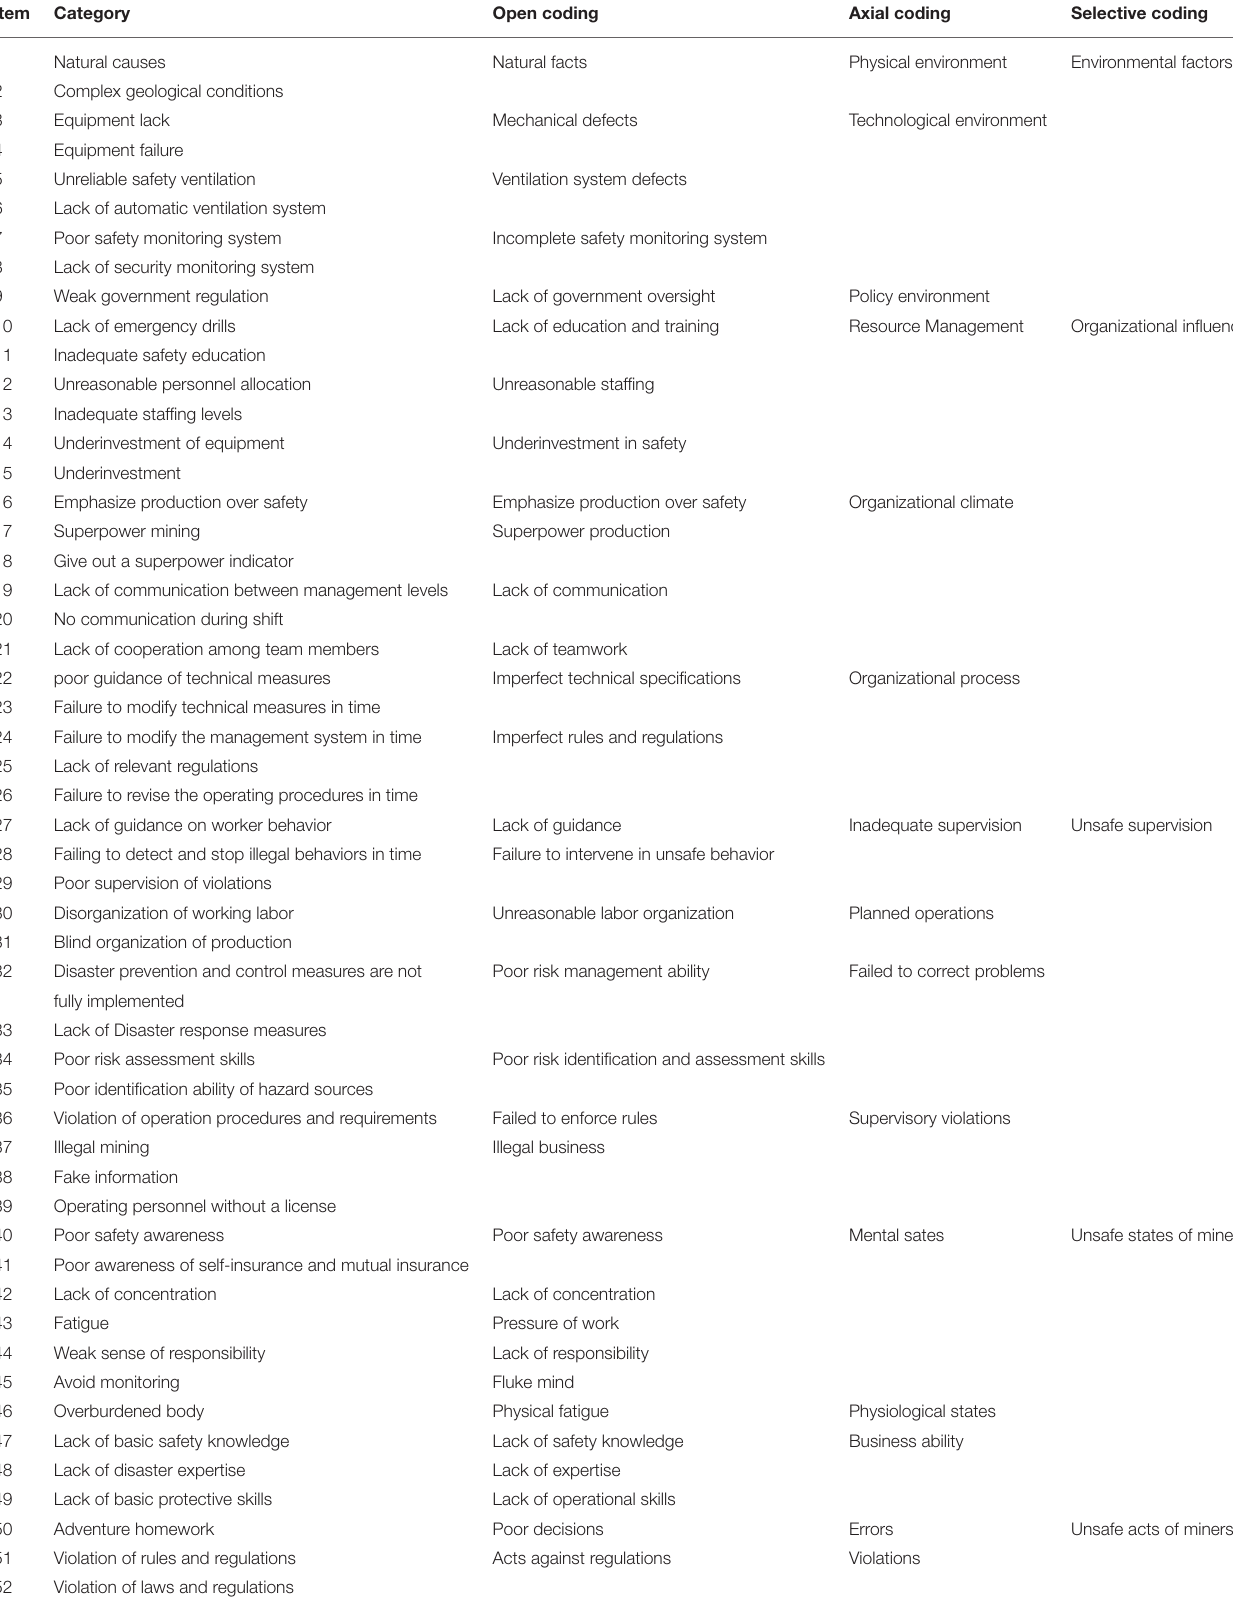
TABLE 4 | Summary of coding